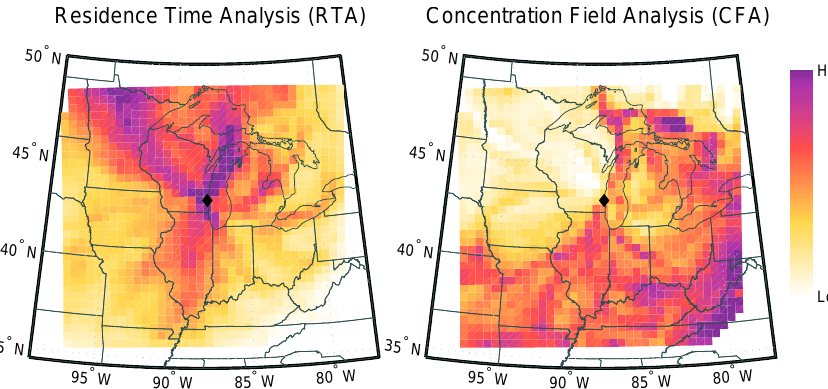
Fig. 6. Residence Time Analysis (RTA, left) and Concentration Field Analysis (CFA, right) for hourly back-trajectories from Milwaukee from 28 June 2004 to 11 May 2005. Measurement site shown by the diamonds. RTA shows dominant surface transport from the northwest, over the lake from the northeast, and from the south through Illinois. CFA shows low potential source regions to the northwest, medium to the south and north and highest towards the Ohio River Valley.